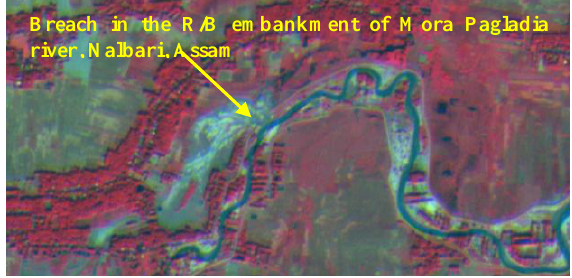
Figure 6. Embankment breach point as seen in Resourcesat-2 (LISS IV) imagery of 2015